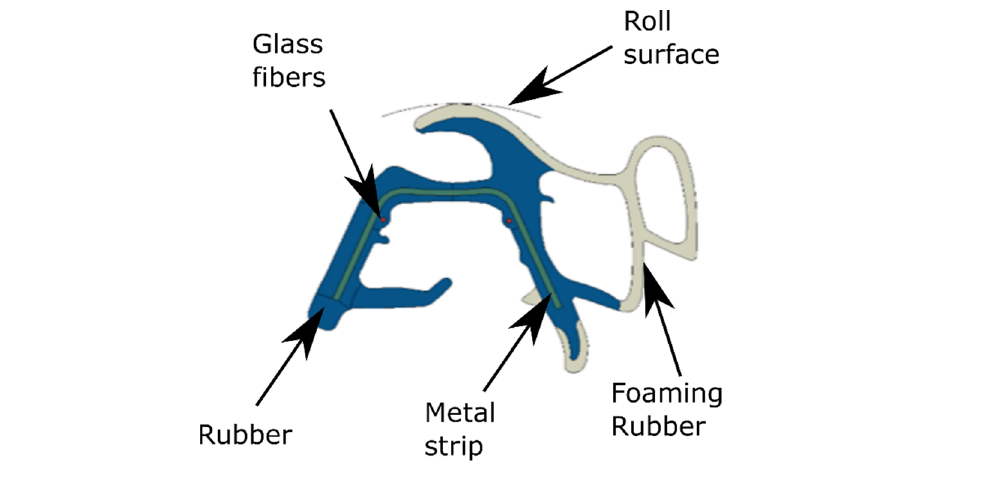
Table 1. Parameters of the FE model.